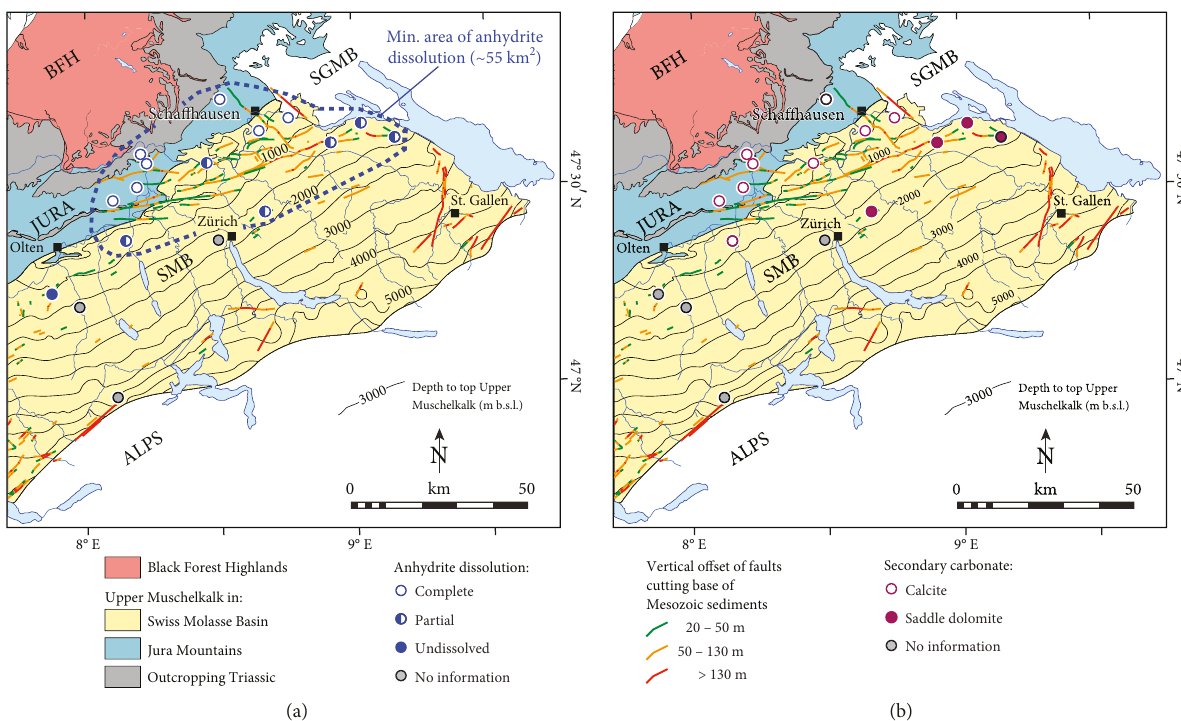
Figure 5: (a) Spatial distribution of anhydrite-dissolution pores within the Trigonodus Dolomit of the NE Swiss Molasse Basin (SMB). Depth contours are in m below sea level (BFH: Black Forest Highlands; SGMB: South German Molasse Basin; modi fi ed after Müller et al. [15] and Sommaruga et al. [24]). Faults emanating from the basement into the Upper Muschelkalk have been deduced from the GeoMol digital subsurface model (this study). See Figure 1(a) and Table A.1 for well names. (b) Spatial distribution of secondary calcite and saddle dolomite fi lling pores and